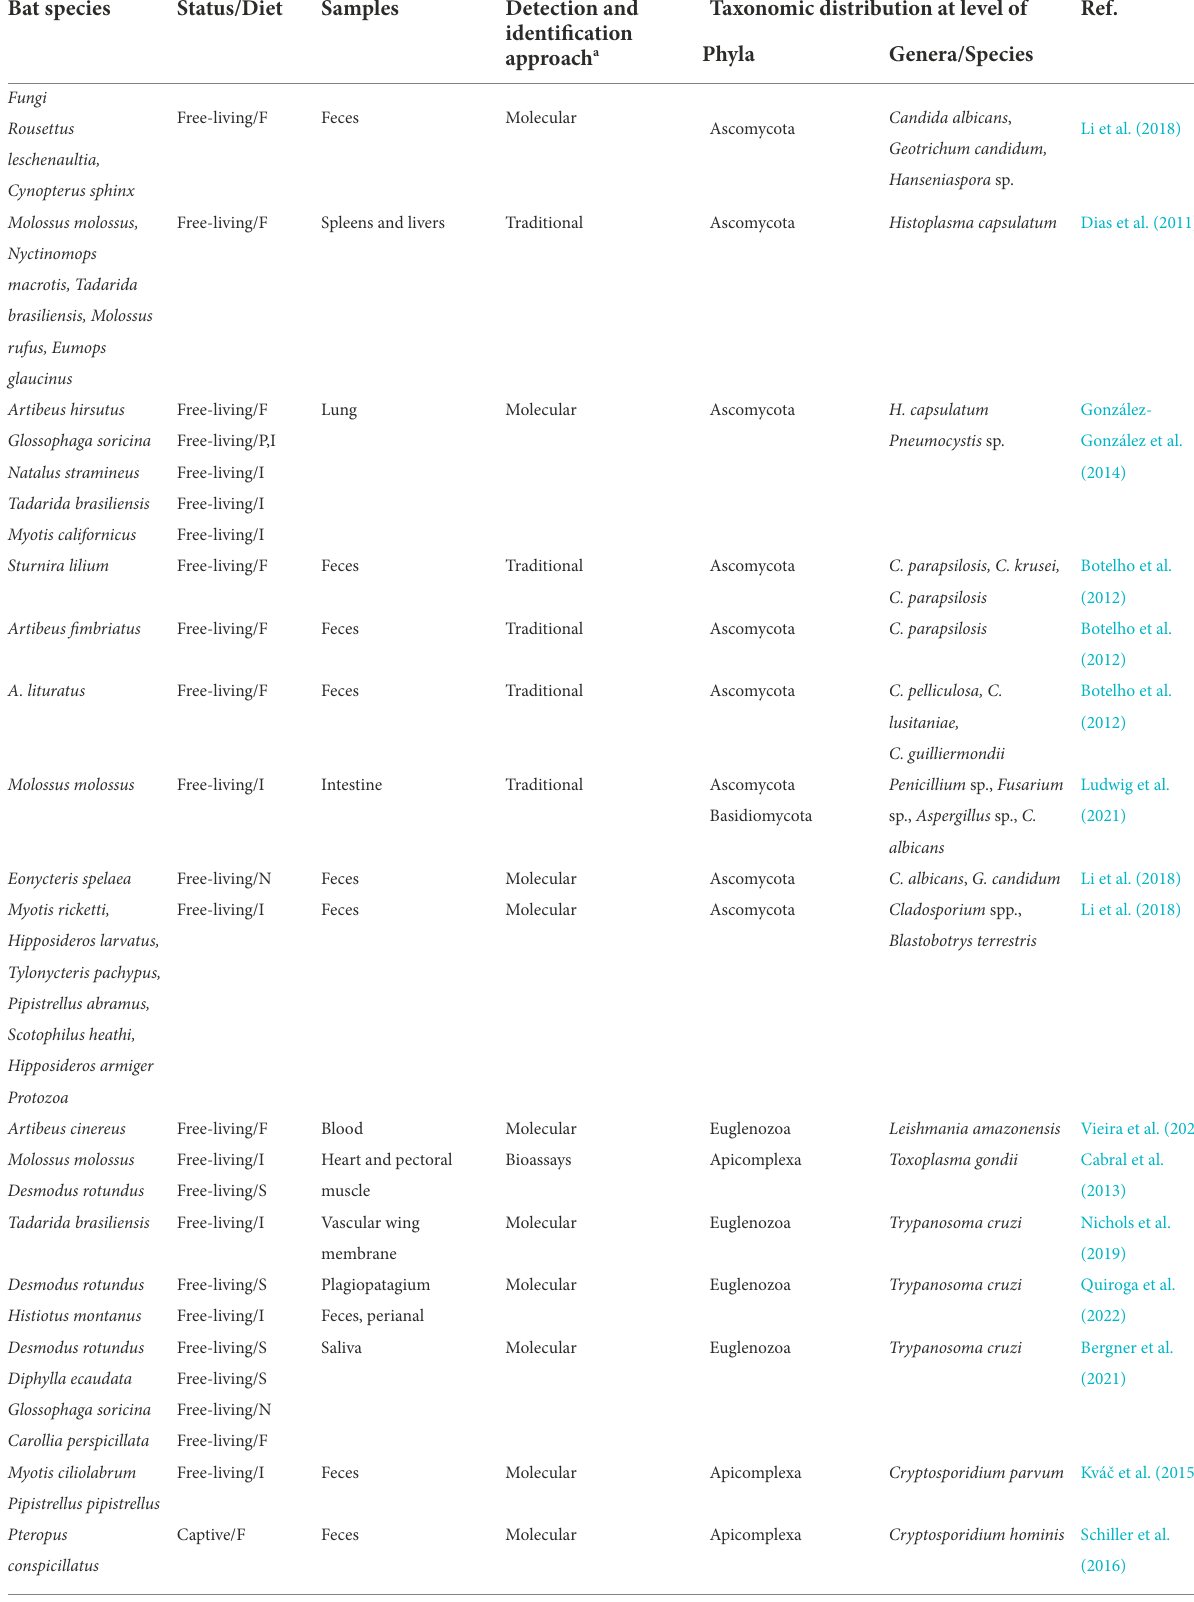
TABLE 2 Taxonomic distribution of commonly widespread eukaryote in